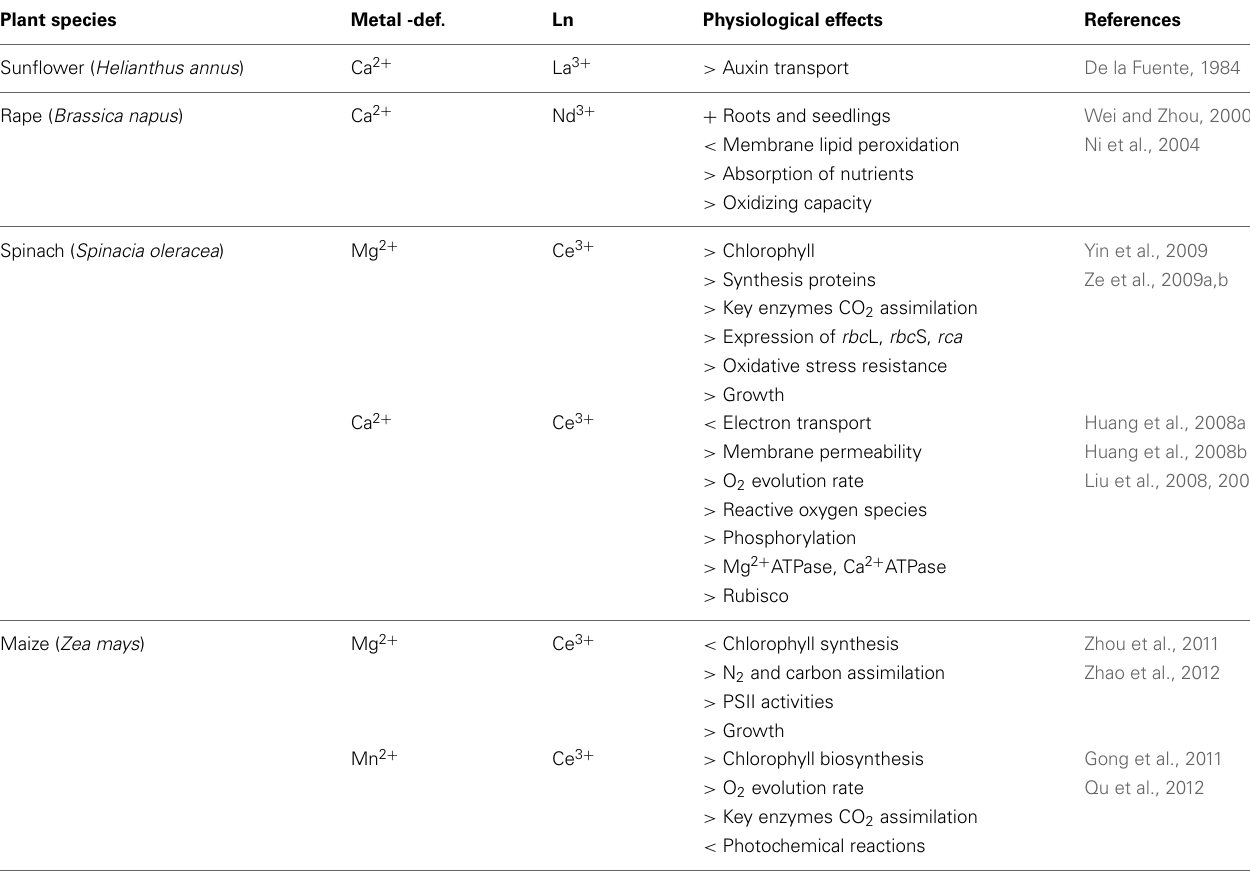
Table 1 | Experiments on the effects of plants under metal deficiency and by exposure to lanthanides. Plant species Metal